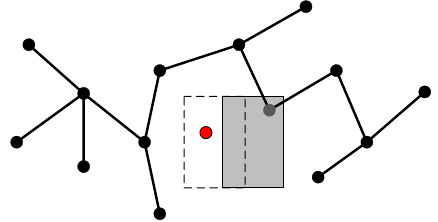
Figure 8. Sample in the area behind the moving